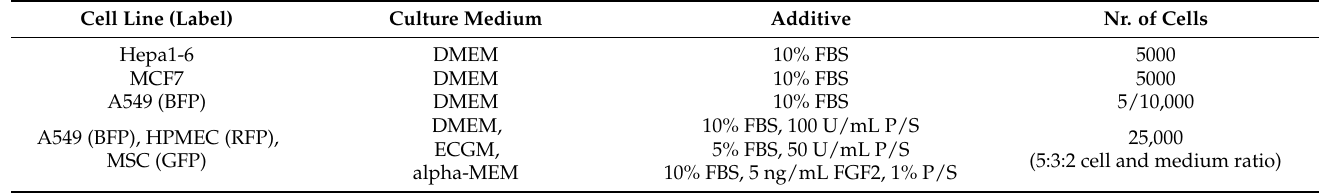
Table 1. Cultured cell lines and culture conditions. FBS: fetal bovine serum, P/S: penicillin/streptomycin, FGF2: fibroblast growth factor 2, BFP: blue fluorescent protein, RFP: red fluorescent protein, GFP: green fluorescent protein.